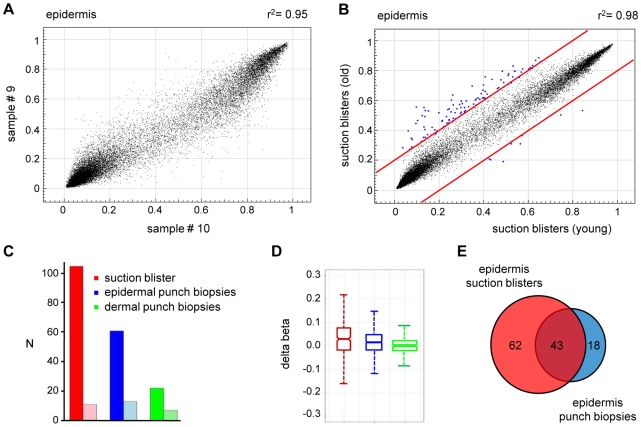
Age-related hypermethylation in human epidermis samples.(A) DNA methylation profiles were compared between epidermal blister samples from two independent old donors. The results show a high similarity with a correlation coefficient of r2 = 0.95. (B) Average epidermal DNA methylation profiles of the study population were compared between old and young epidermis samples. The results reveal a distinct trend towards age-associated hypermethylation. (C) Barplot illustrating the results from an independent statistical analysis of the array data. The number of substantially hypermethylated (Δ(beta)≥0.2, P(BH)<0.01) markers is shown in dark colors, the number of substantially hypomethylated (Δ(beta)≤−0.2, P(BH)<0.01) markers is shown in light colors. (D) Boxplot illustrating age-related methylation changes in human epidermis and dermis samples. (E) A comparison of substantially hypermethylated markers from two independent sets of epidermis samples (suction blisters and punch biopsies) reveals a large overlap of 43 commonly hypermethylated markers.